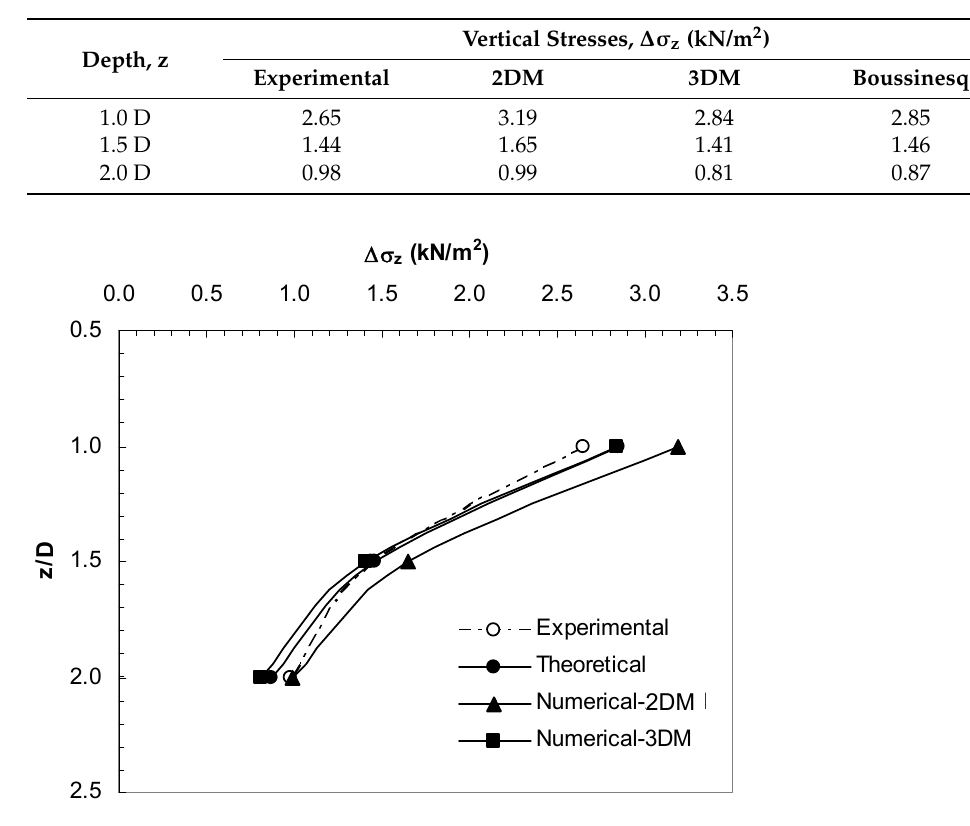
Figure 8. Vertical stress distribution beneath the 85 mm circular footing.